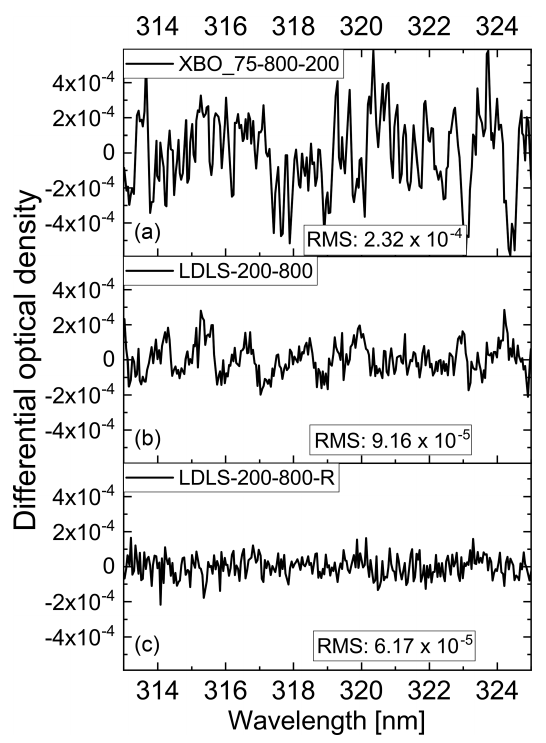
Figure 9. Examples of residual spectra and corresponding root- mean-square (rms) values for the benchmark configuration with a XBO_75W arc lamp and a classical fibre configuration (a) , the new LDLS light source and a reversed fibre bundle (b) , and the new LDLS reversed fibre bundle and roughened fibre ends (c) . The lat- ter was found to give the best